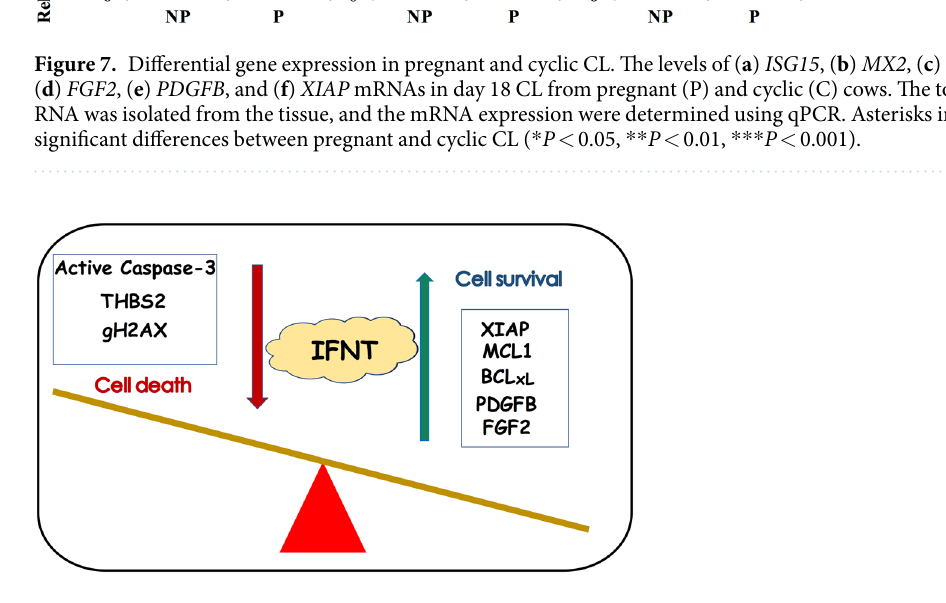
Figure 8. Illustrative summary depicting IFNT actions balancing life and death of bovine LGCs. IFNT elevates viable LGCs numbers, reduces apoptotic cells, and increases prosurvival proteins including XIAP, MCL1, and BCL-xL. Concurrently with its prosurvival effects, IFNT stimulates proangiogenic factors—FGF2, PDGFB. Conversely, antiapoptotic factors, active caspase-3, THBS2 and gH2AX are inhibited by IFNT. These findings portray IFNT as a prominent luteal survival